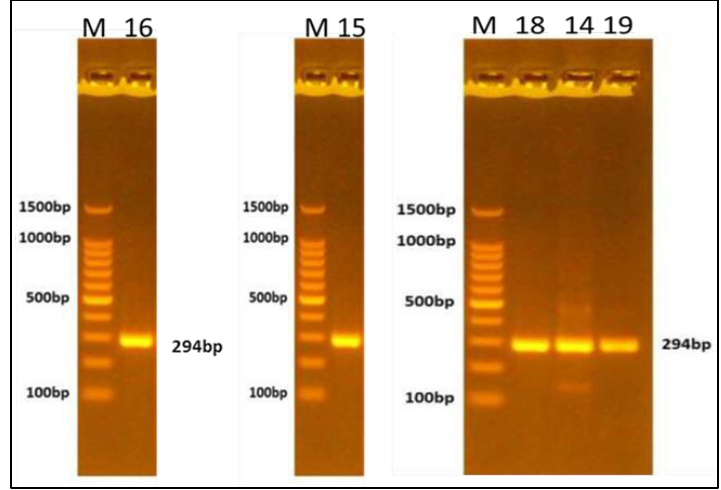
Figure 5. Results of presence of hsp65 gene with 294 bp, fractionated on1% agarose gel electrophoresisstained withethidium bromide. Lane M=100 bp DNA ladder. Lanes 14, 15, 16, 18, and 19= positive